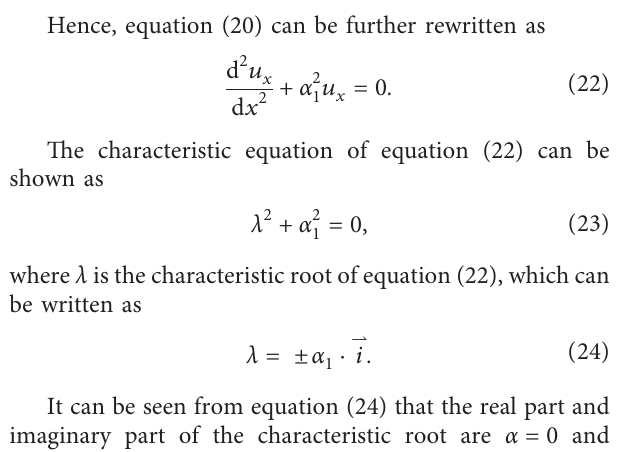
Figure 9: Mechanical model of the anchor bolt of zonal disinte- gration in deep underground cave.